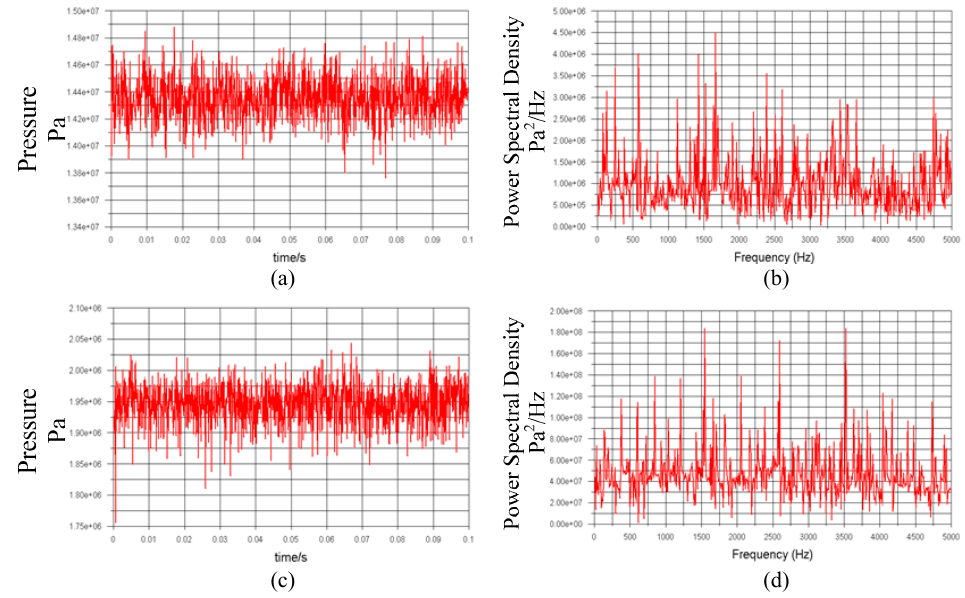
Figure 14. Pressure oscillation curve of the flapper when the displacement of the flapper is x = 0.10 mm. ( a ) Point 1 in the time domain. ( b ) Point 1 in the frequency domain. ( c ) Point 2 in the time domain. ( d ) Point 2 in the frequency domain.